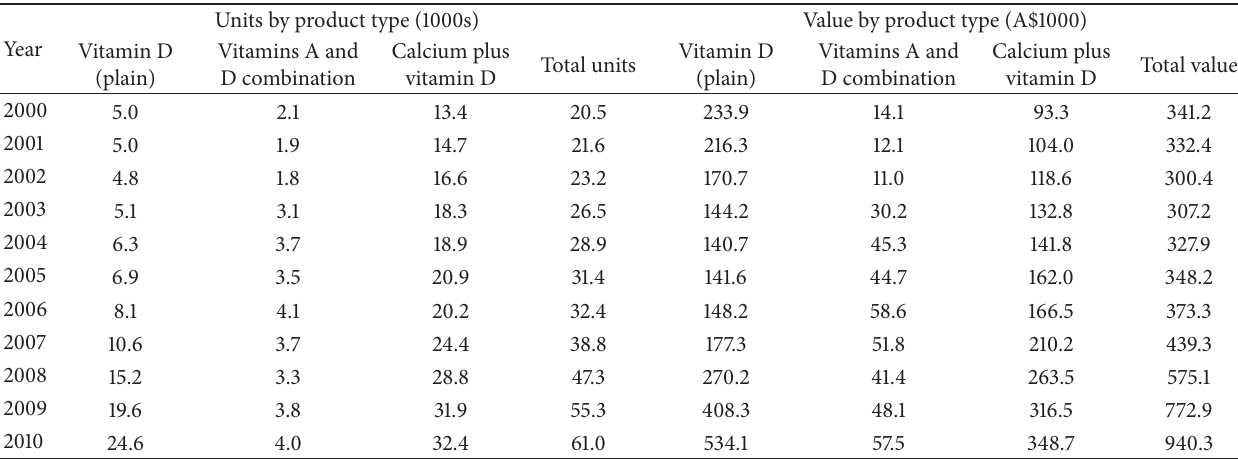
Table 1: Annual vitamin D containing supplement sales in thousands of units 1 and thousands of dollars according to year and product type. Units by product type (1000s) Value by product type (A$1000) Year Vitamin D Vitamins A and Calcium plus Vitamin D Vitamins A and Total units (plain) vitamin D (plain) vitamin